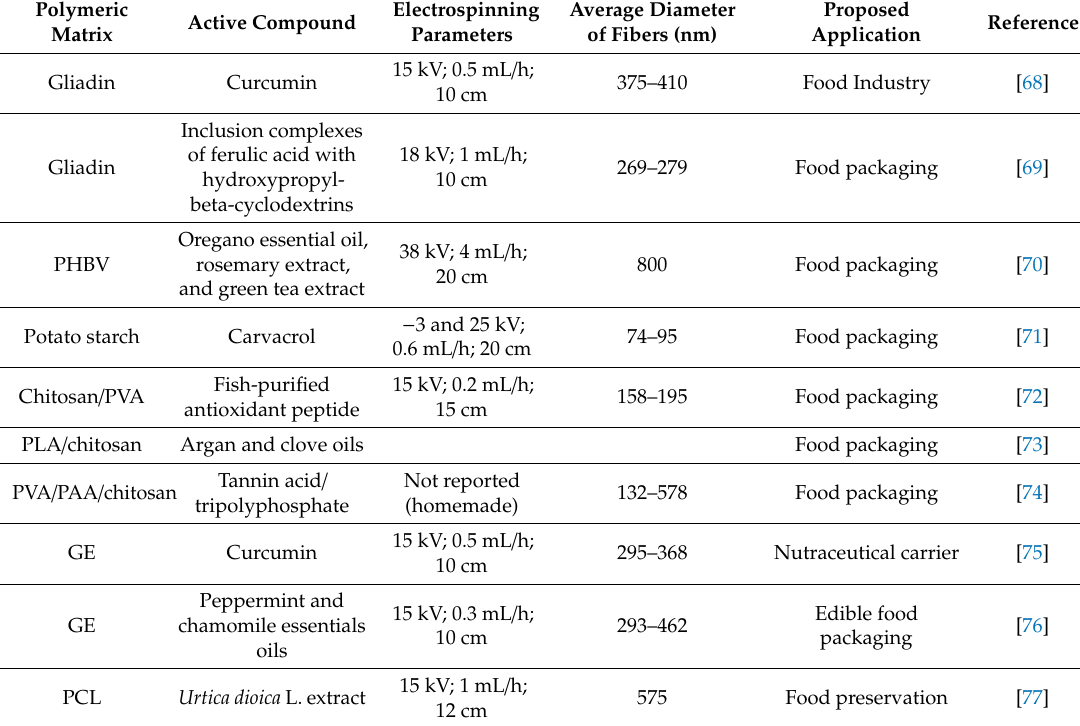
Table 5. Characteristics of antioxidant nanofibers from 15 reviewed articles and proposed applications in